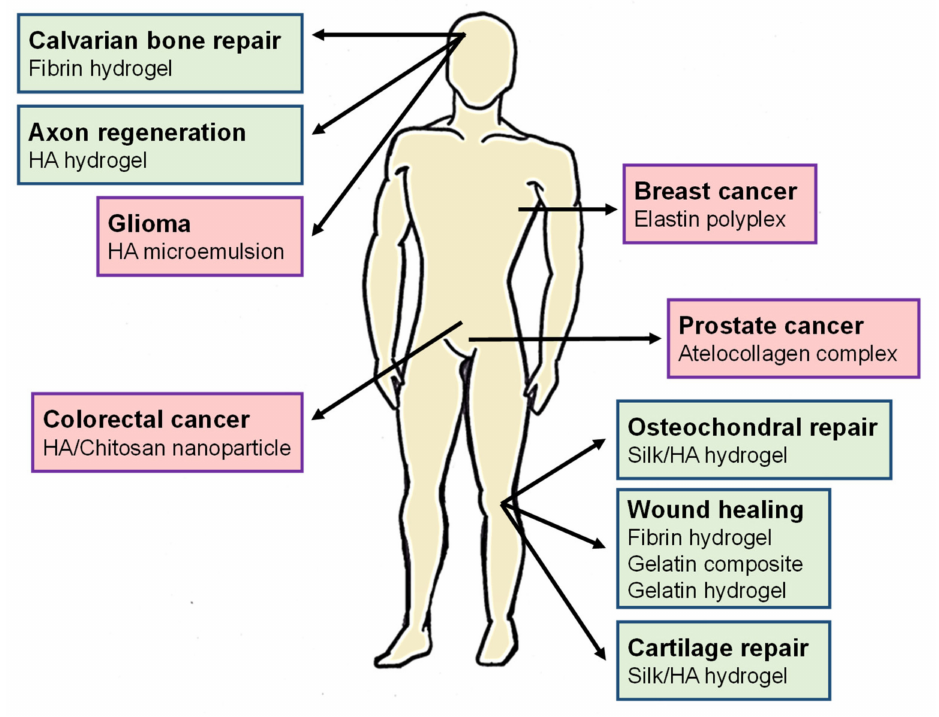
Figure 1. Scheme of the biomedical applications and their therapeutical approaches described in this